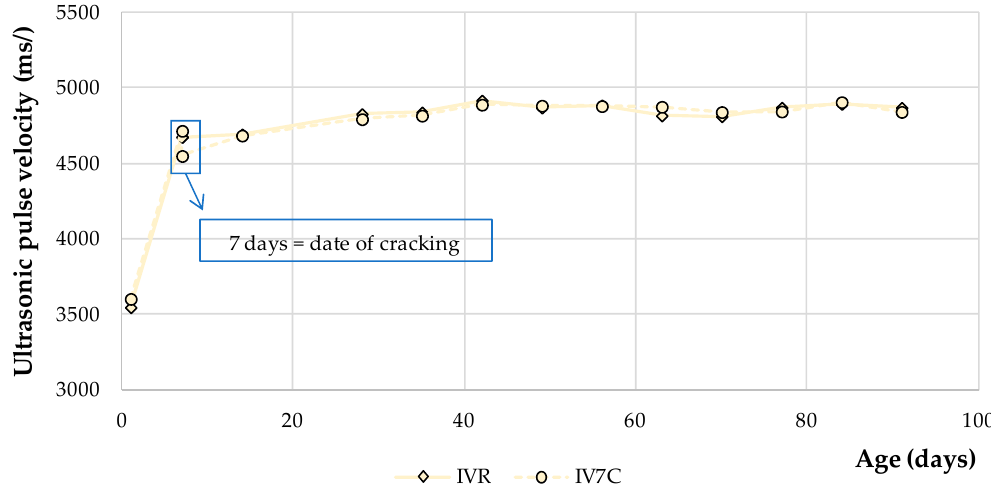
Figure 4. Ultrasonic pulse velocity of uncracked concrete (IR) and 7 day cracked concrete (I7C) with CEM I.